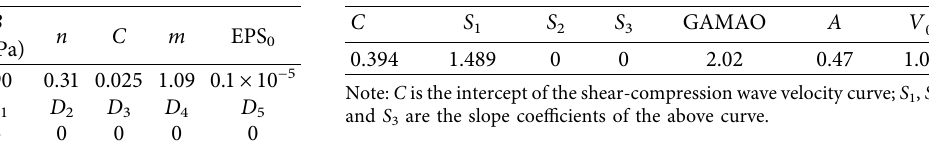
Table 2: Material parameters of copper in the model. Table 3: State equation parameters of copper.